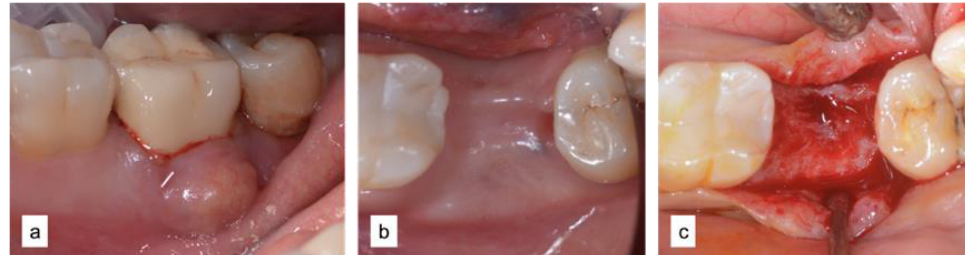
Figure 2. Patient 1. ( a ) Preoperative image of tooth 47. ( b ) Soft tissue healing at 4 months. ( c ) Bone healing at 4 months.